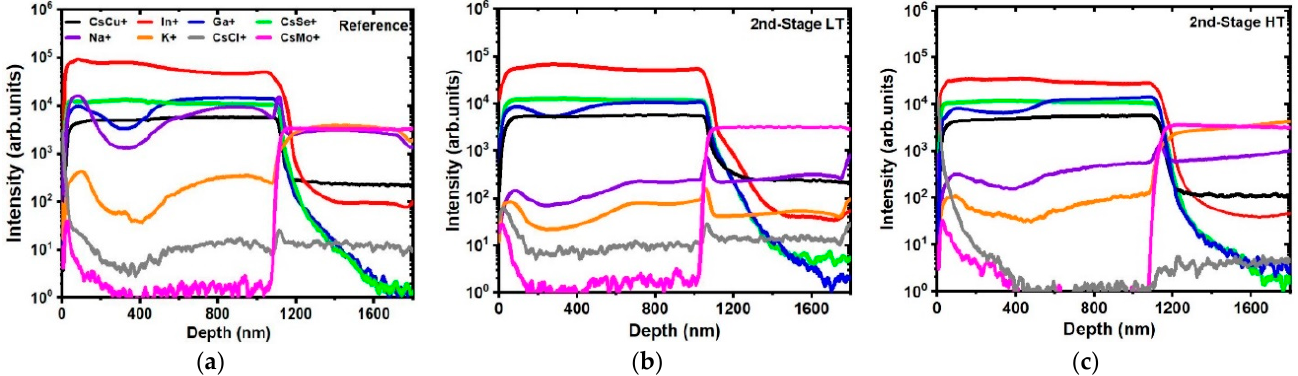
Figure 3. Secondary Ions Mass Spectroscopy (SIMS) depth profile (positive ions) of the main elements for the reference ( a ), second stage LT ( b ) and second stage HT ( c ) CuCl 2 annealed CIGS sample.